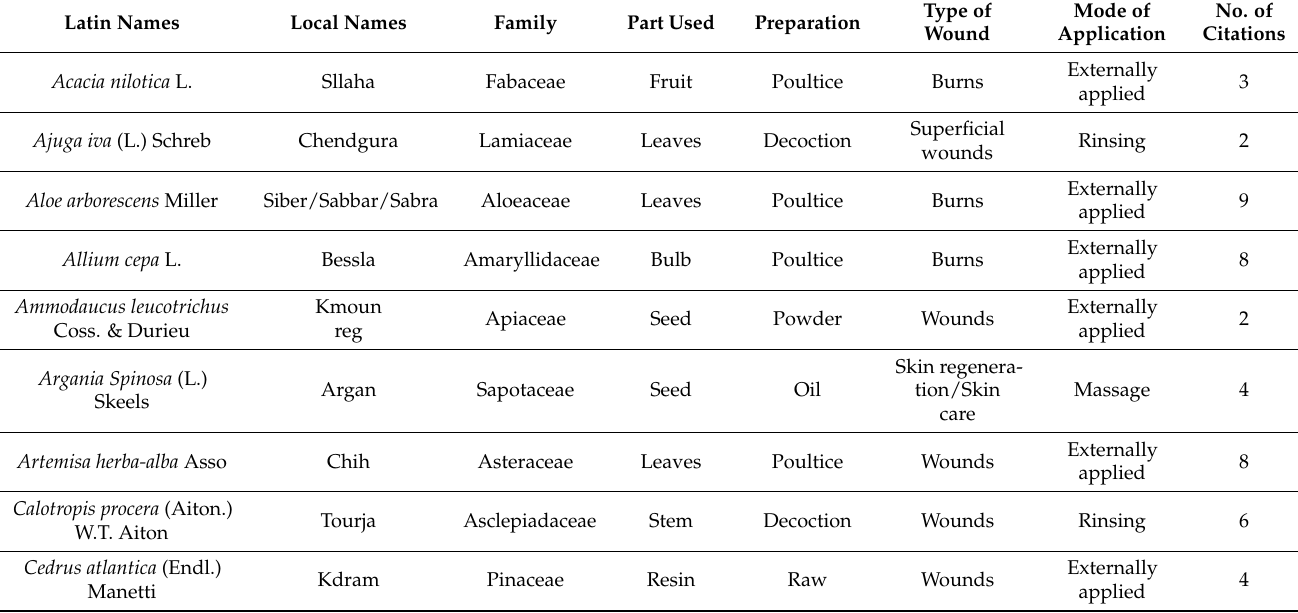
Table 4. Medicinal plants used in the treatment of wounds in Morocco as identified by the ethnophar- macological